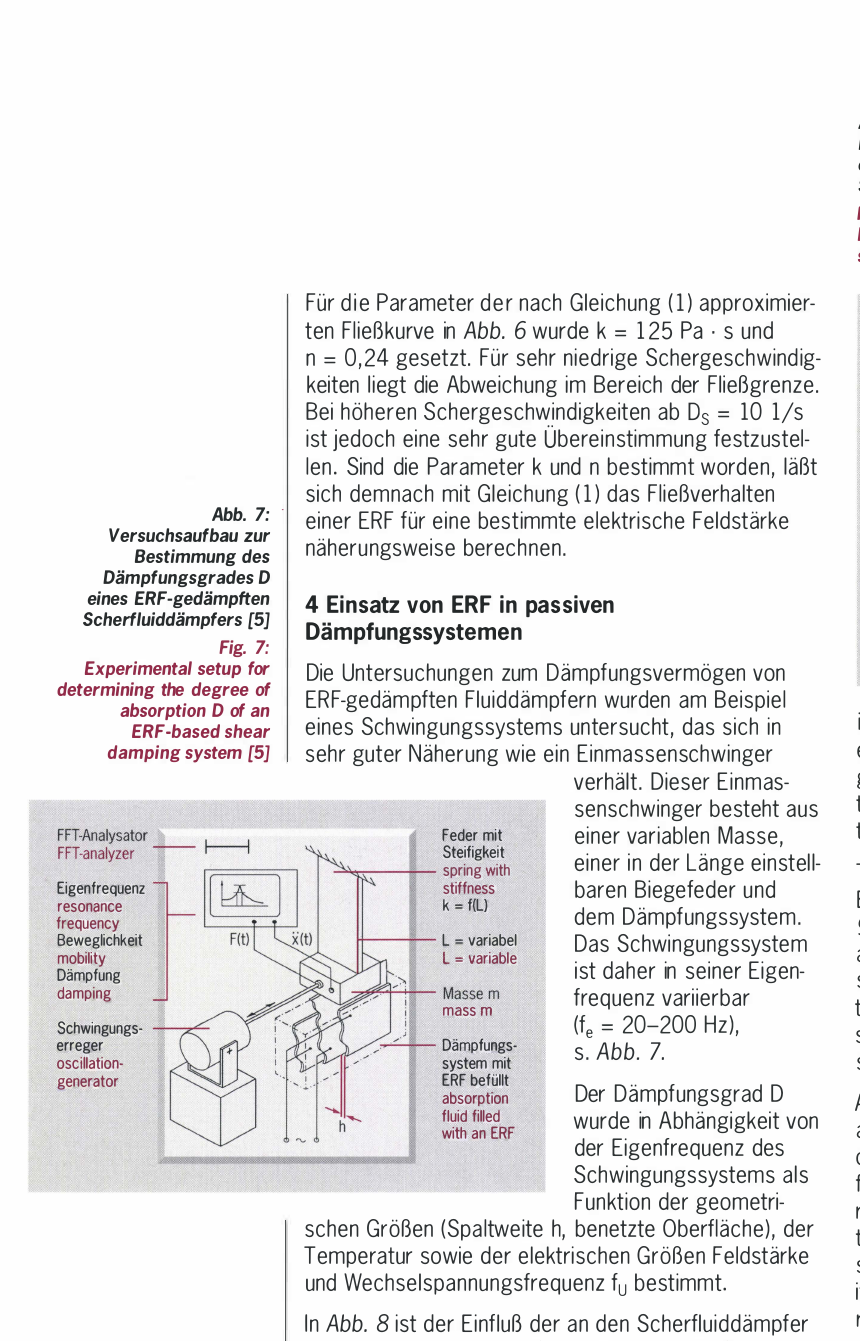
Fig. 8: Degree of absorption D of an ERF-based shear damping system as a function of applied current